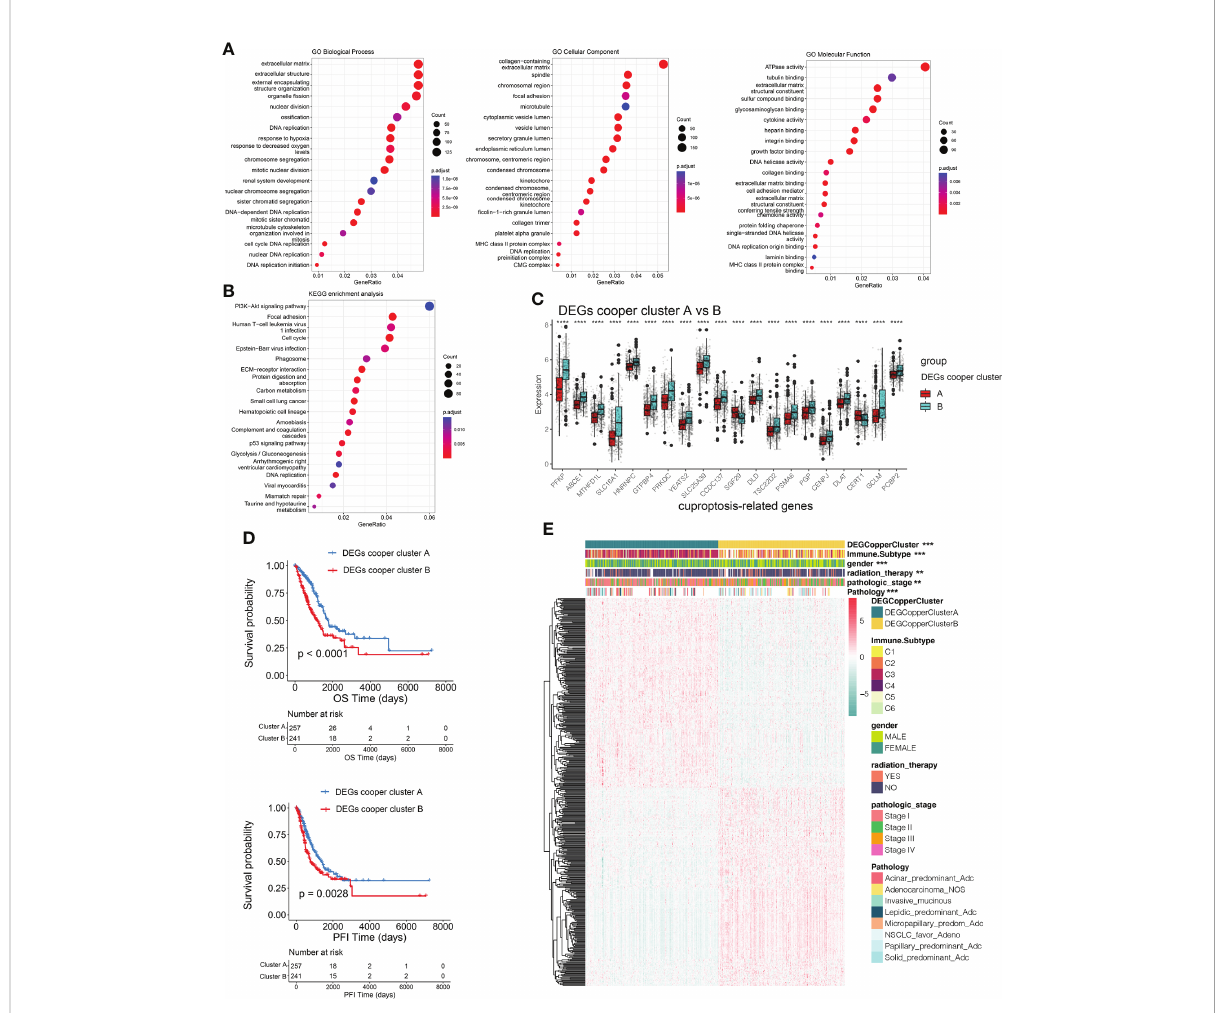
FIGURE 4 Identi fi cation of DEGs subtypes based on cuproptosis consensus clusters. (A, B) GO and KEGG enrichment analyses of DEGs among two cuproptosis consensus clusters. (C) Differences in the expression of CRGs among the two DEGs subtypes. (D) Kaplan – Meier curves for OS and PFI of the two DEGs subtypes (DEG Copper Cluster A: 260; DEG Copper Cluster B: 247) (log-rank tests, p <.001). (E) Relationships between clinicopathologic features and the two DEGs subtypes. **P<0.01, ***P<0.001, ****P<0.0001. DEGs, differentially expressed genes; GO, Gene Ontology; KEGG, Kyoto Encyclopedia of Genes and Genomes; CRGs, cuproptosis-related genes; PFI, progression free interval; OS, overall